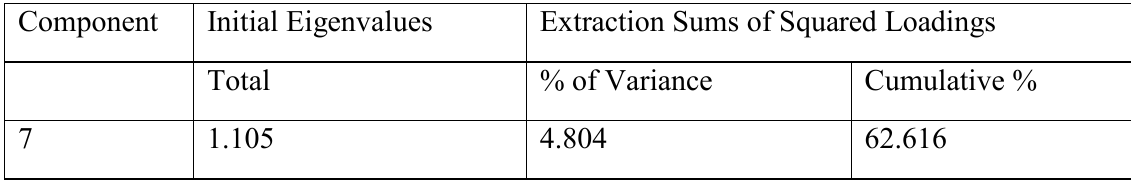
Table 1.51: Variance explained for Transformative Resilience PC7